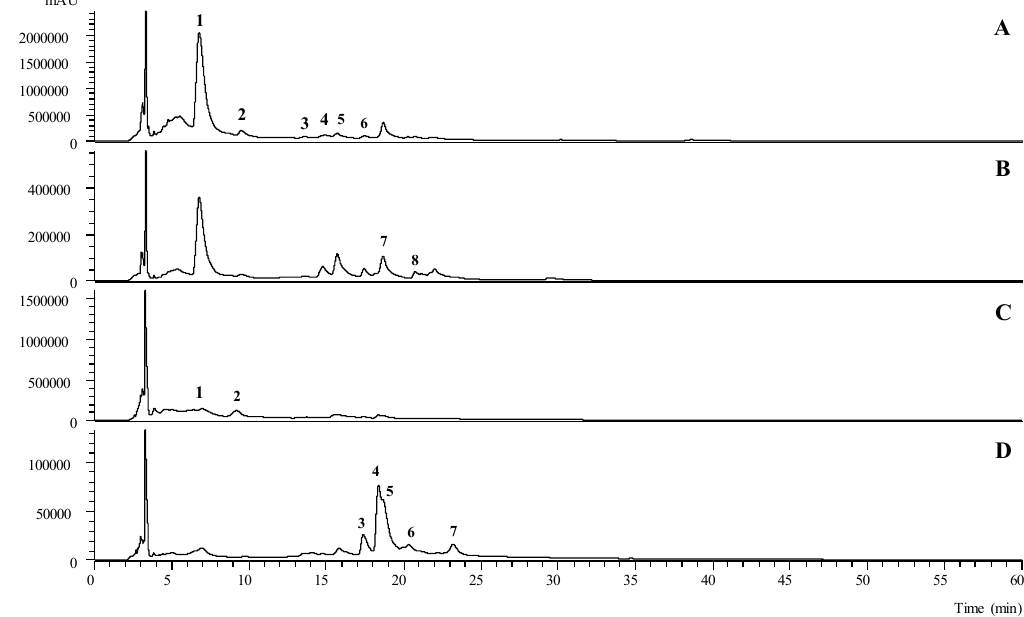
Figure 4. Chromatographic profile of B. vulgaris and C. monogyna recorded at 280 nm (( A ) and ( C ), respectively) and 370 nm (( B ) and ( D ), respectively). Table 1. The retention time (Rt), wavelengths of maximum absorption ( λ max ), tentative identification, mass spectral data, and quantification of phenolic compounds identified in the extracts of B. vulgaris and C. monogyna (Mean ± SD). MS 2 Rt λ Max [M − H] − Peak ( m / z ) (min) (nm)